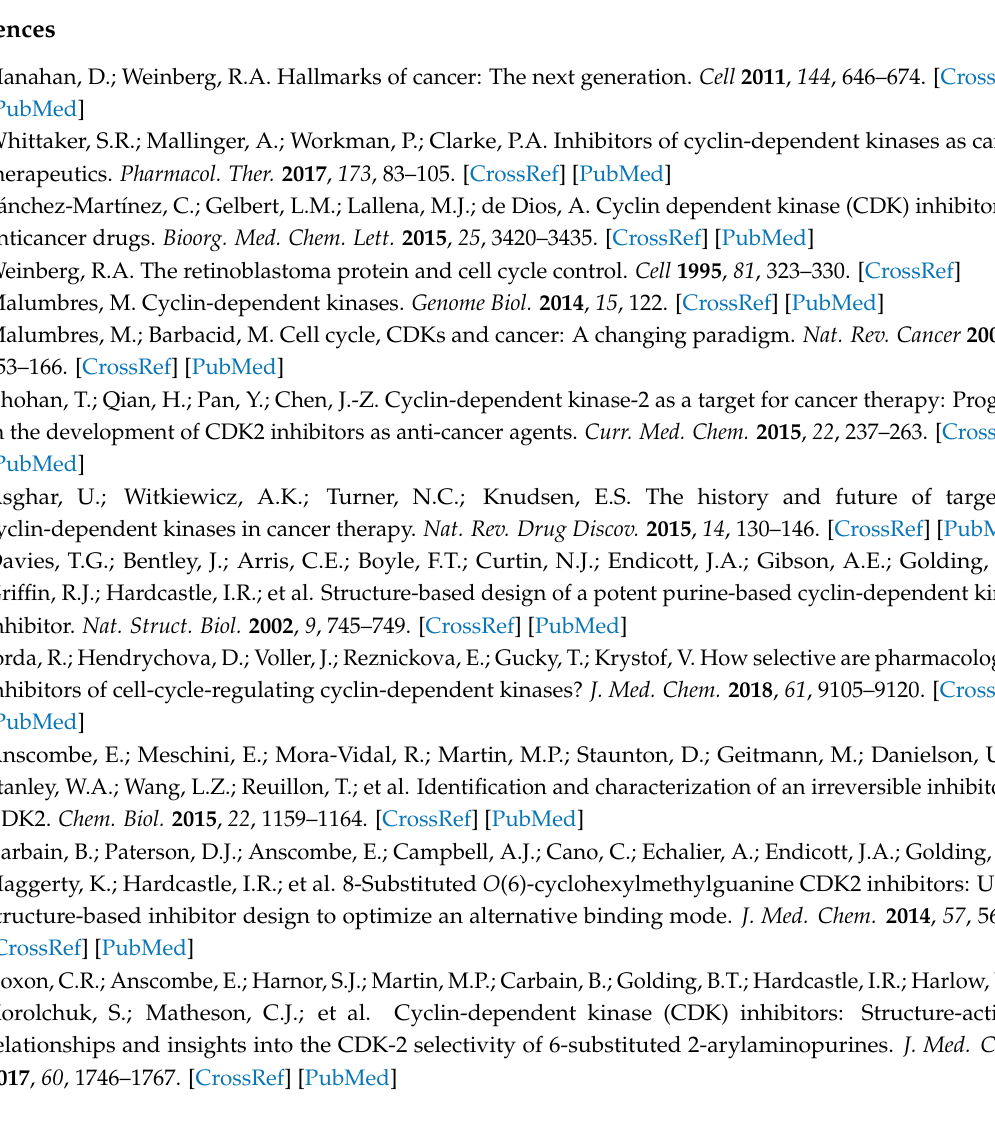
model, Table S1: The PLS statistical results of CoMFA and CoMSIA models, Table S2: The structures, predicted pIC 50 values of the newly designed candidate compounds, Table S3: Docking results of the dataset compounds, Table S4: Docking results of the newly designed candidate compounds. Author Contributions: The computational experimental work and result analysis were performed by G.Z.